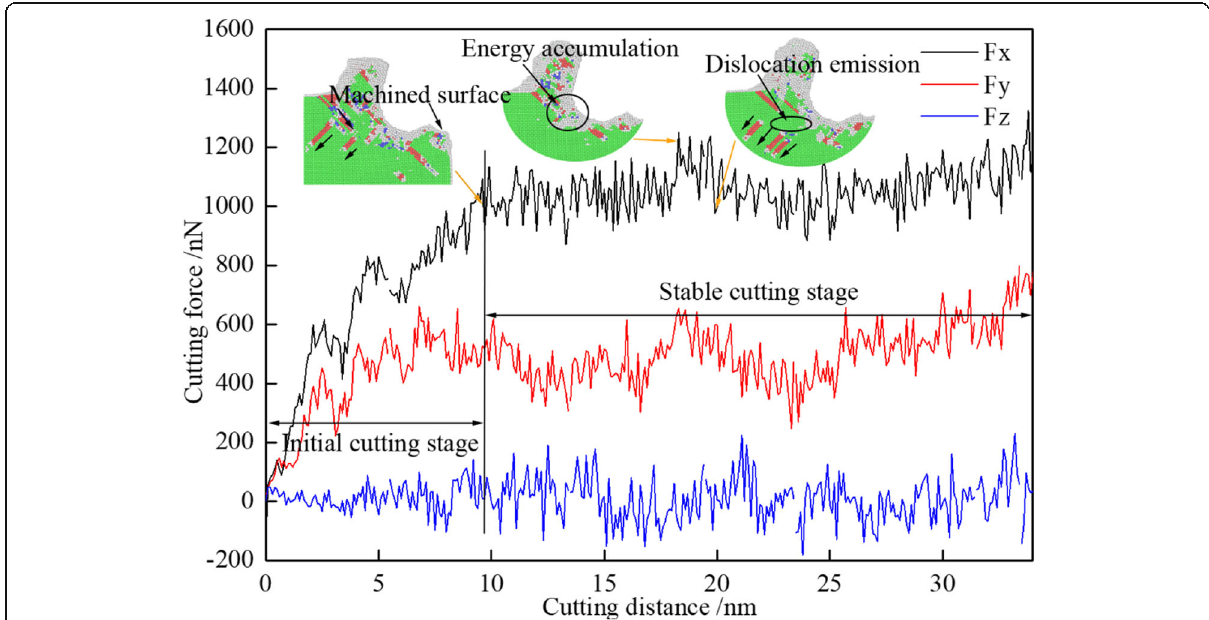
Fig. 3 The variation curve of cutting force with the cutting distance (color online). The black, red, and blue curves respectively are the feed force (Fx), the back force (Fy), and the tangential force (Fz) stress and energy in the shear-slip zone, shown in Fig. 4b. In the subsequent processing process, the shear-slip zone is moved forward with the cutting tool keep moving. Due to the deformation energy de- creasing, the fault is gradually annihilated. During the cutting tool keep moving forward, the flank face fric- tion zone is moved near the fault. And the roughness machined surface is formed under the extrusion and friction of the flank face. Then the fault is continued